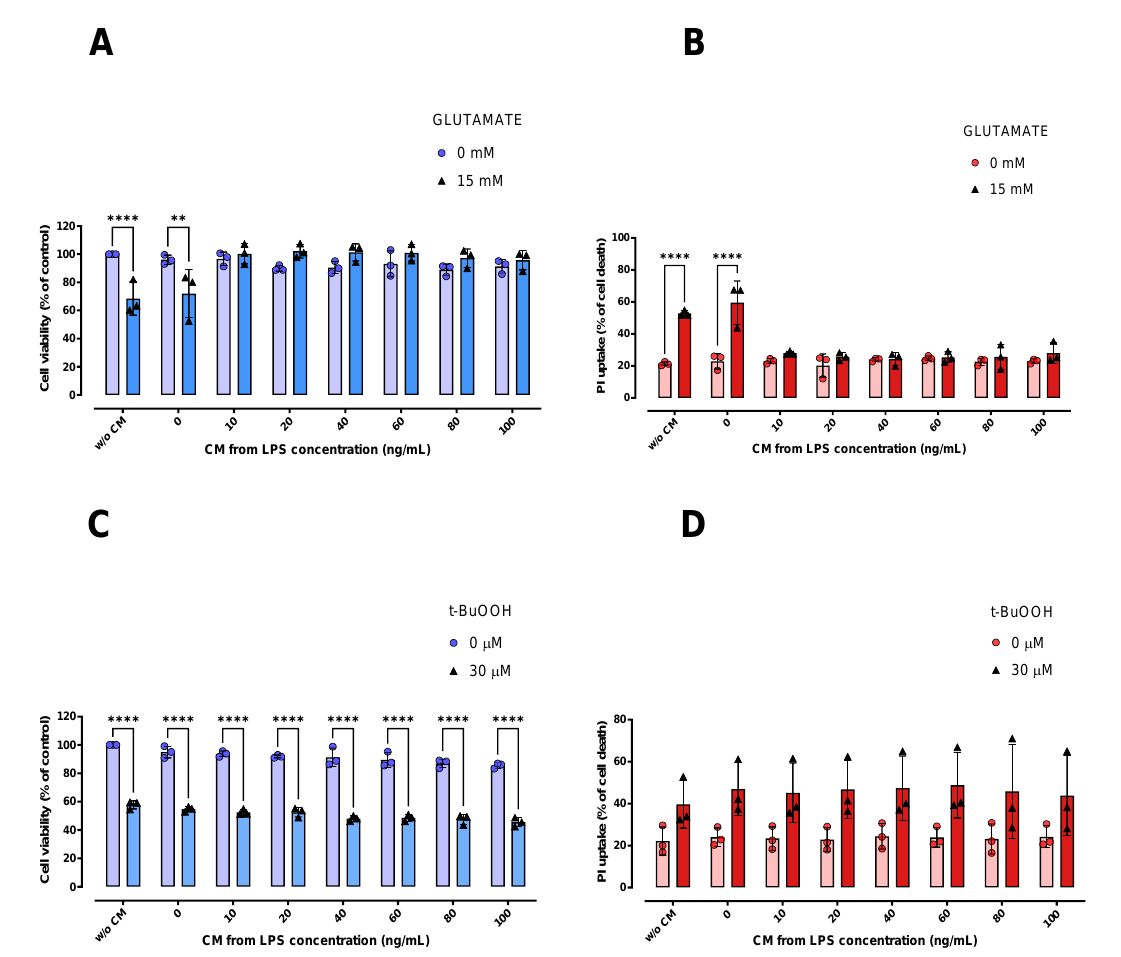
Figure 4. Effects of CM on protection against damage caused by glutamate and t -BuOOH in HT22 cells. HT22 cells exposed for 6 h to CM showed protection against cytotoxicity induced by 15 mM glu- tamate ( A , B ). However, this was not observed in the t -BuOOH paradigm ( C ). ** p < 0.01; **** p < 0.0001 compared to the respective controls (cells not treated with glutamate or t -BuOOH; n = 3). In ( B , D ), 100% cell death is represented by cells treated with 0.2% Triton X-100 for 20 min. n =